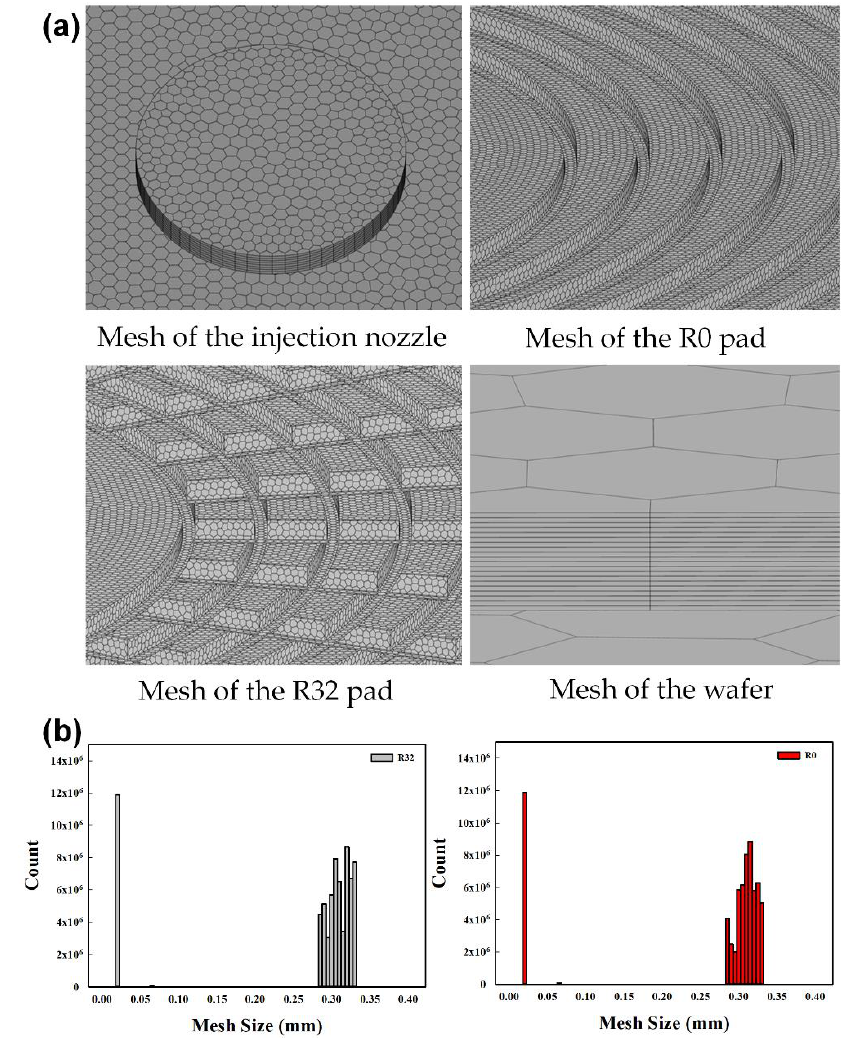
Figure 5. ( a ) Parts of the mesh models for simulation, and ( b ) mesh size distribution of R0 and R32 pad.